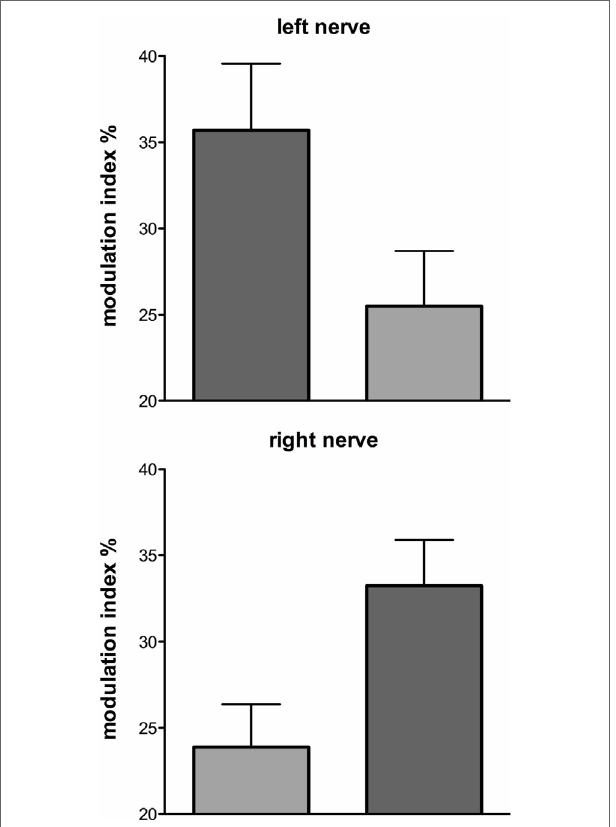
FiGURe 7 | Mean ± SE modulation indices for the primary (dark gray) and secondary (light gray) peaks of modulation of muscle sympathetic nerve activity. Data obtained from 10 subjects. Reproduced with permission from El Sayed et al. (58).